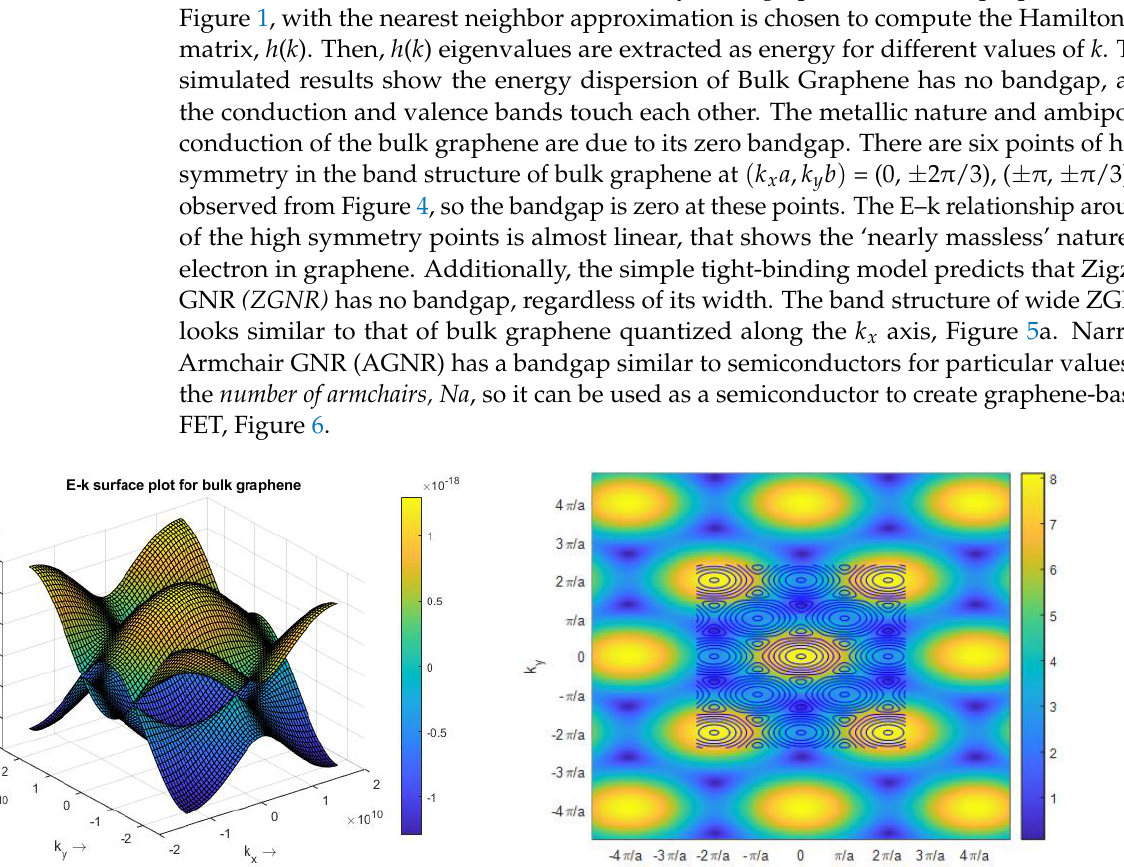
( b ) Figure 5. Energy dispersion. ( a ) Energy versus 𝑘 𝑦 ( 𝑘 𝑥 = 0 ); ( b ) energy versus 𝑘 𝑥 ( 𝑘 𝑦 = 0 ). ( a )